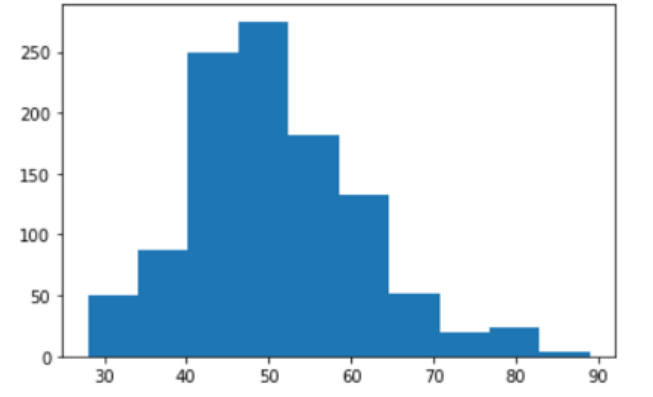
Figure 6. Age distribution.